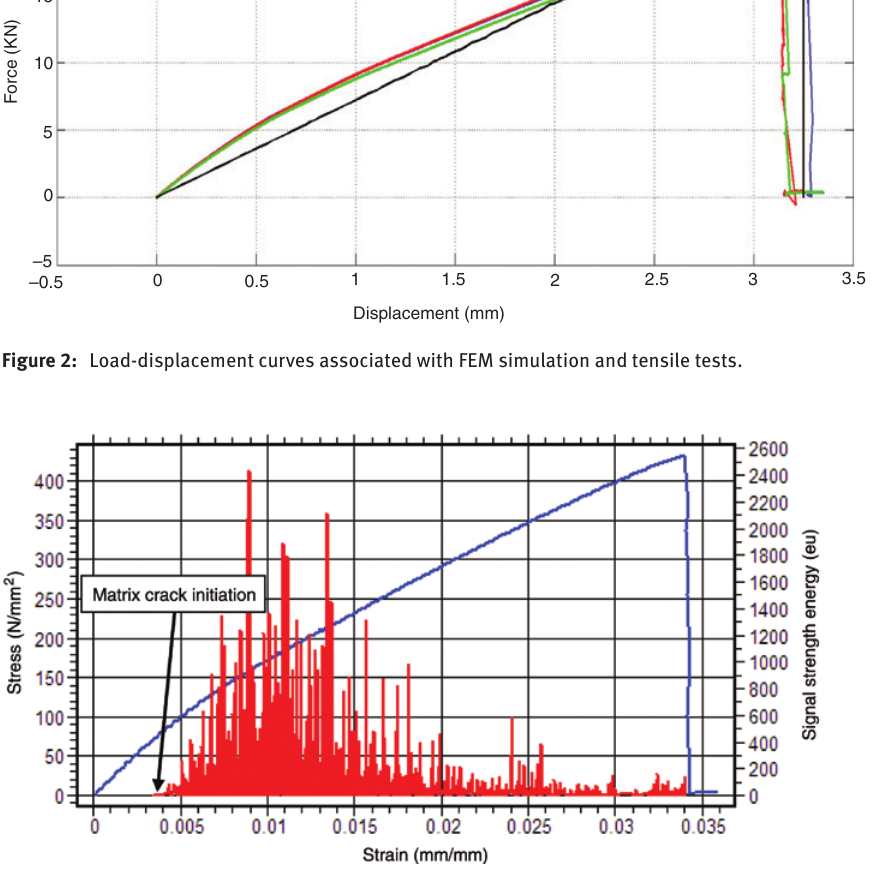
Figure 3: Stress-strain curve superimposed with acoustic emission energy data for specimen